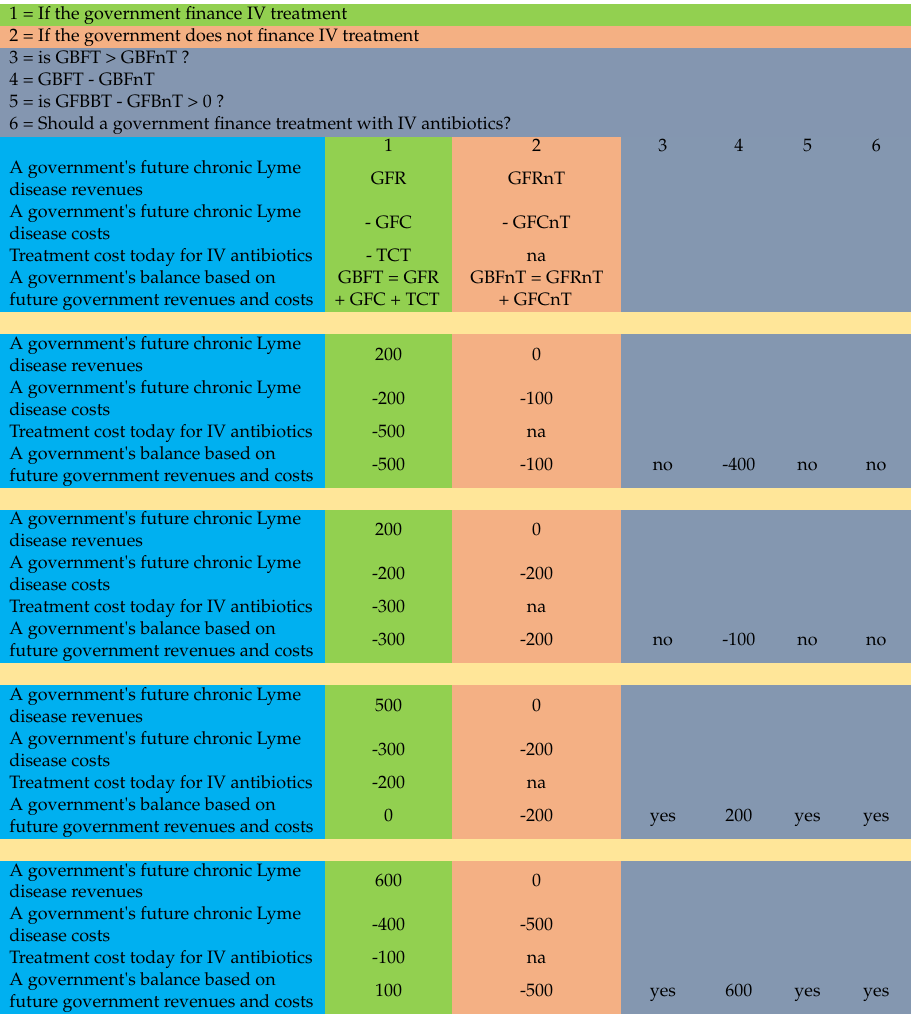
Table 17. A government’s financial IV treatment decision regarding chronic Lyme